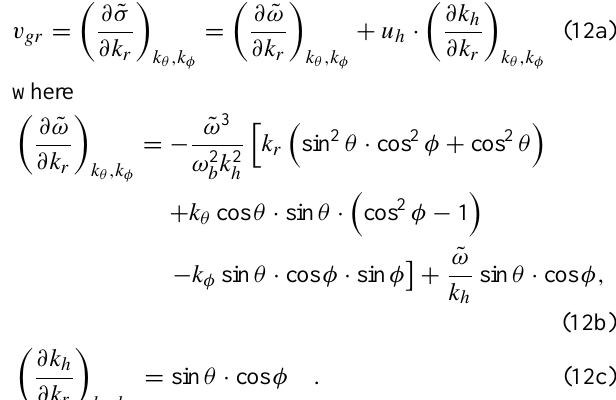
Fig. 1. Relative directions of the radar beam and the horizontal wave vector of gravity wave.